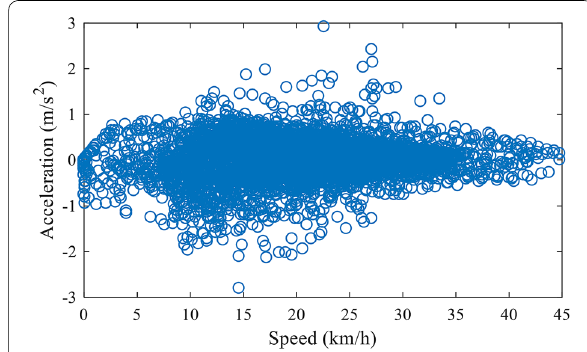
Figure 4 Distribution of vehicle speed and acceleration